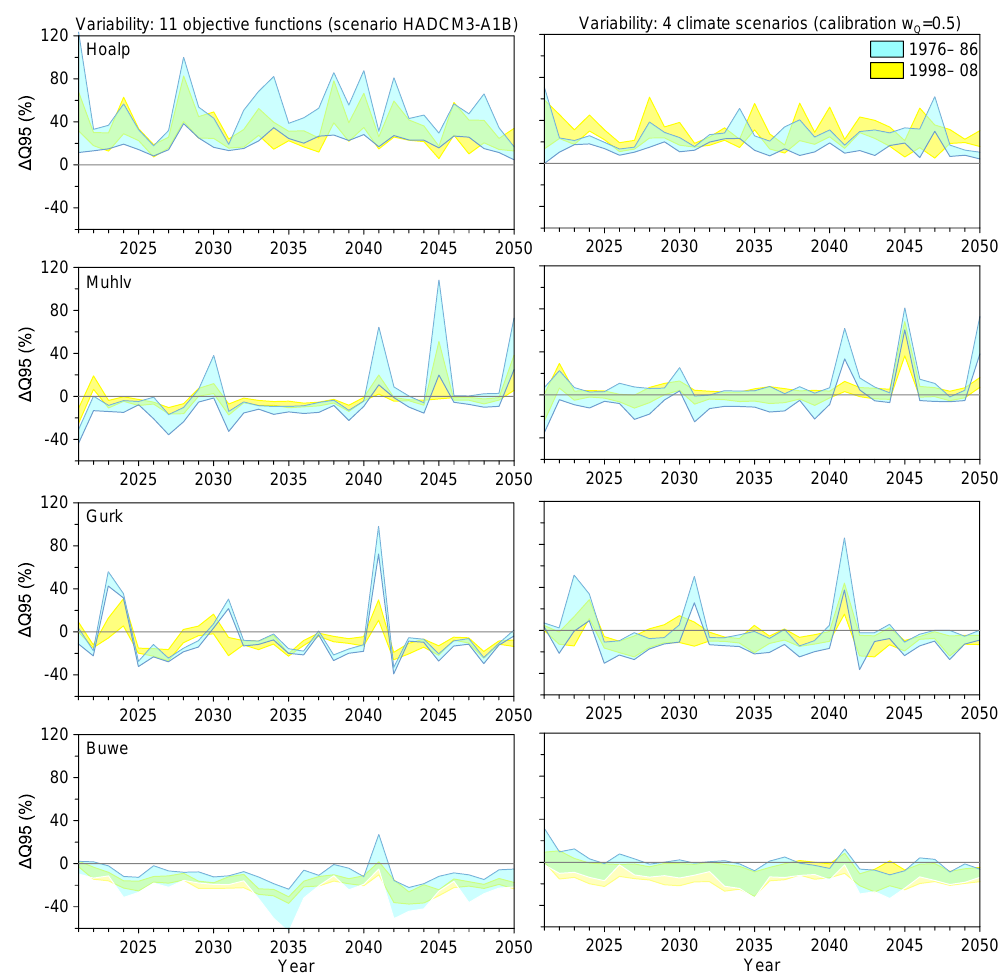
Figure 6. Projections of annual Q 95 low flows for the four catchments in terms of changes of the future period (2021–2050) relative to simulated runoff in the reference period (1976–2008). Band widths in the left panels show the variability due to different weights w Q in the objective function (Table 3) using HADCM3. Band widths in the right panels show the variability due to the choice of climate projections for calibration variant w Q = 0.5. Yellow and blue colours relate to two calibration periods for the hydrological